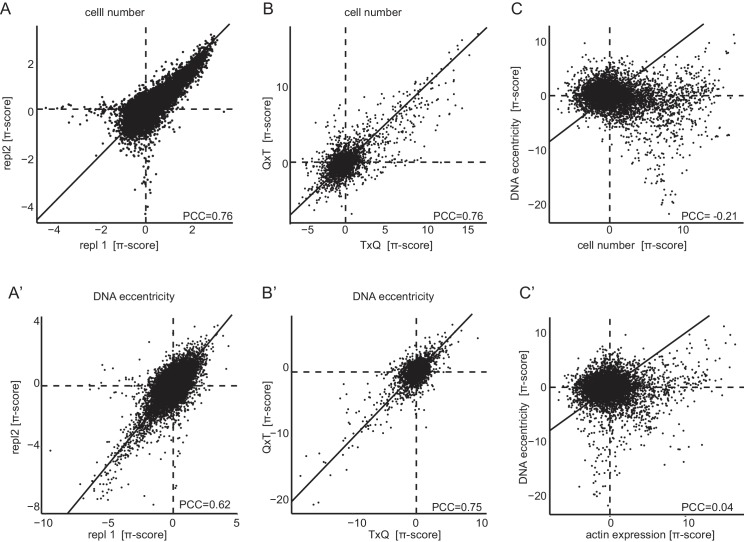
Genetic interactions are reproducible, permutation agnostic and non-redundant.Interactions measured by π-scores were analyzed for one representative condition (Dsor1 inhibition 96 hr). (A,A’) Reproducibility of π-scores between biological replicates is high for the exemplary features ‘cell number’ and ‘DNA eccentricity’, PCC = 0.76 and PCC = 0.62. (B,B’) Similar correlations, PCC = 0.76 and PCC = 0.75 respectively, are obtained when comparing the query-target (QxT) interaction with the target-query (TxQ). Both combinatorial variants are measured independently in this experiment for half of all target genes. (C,C’) Weak linear correlation between genetic interactions caluclated for different phenotypic features indicates non-redundancy of multiparametric interactions (PCC of −0.24 between ‘DNA eccentricity’ and ‘cell number’ and 0.04 between ‘DNA eccentricity’ and ‘actin level’). Diagonal lines were drawn to indicate the identity. Horizontal and vertical lines indicate zero crossing.